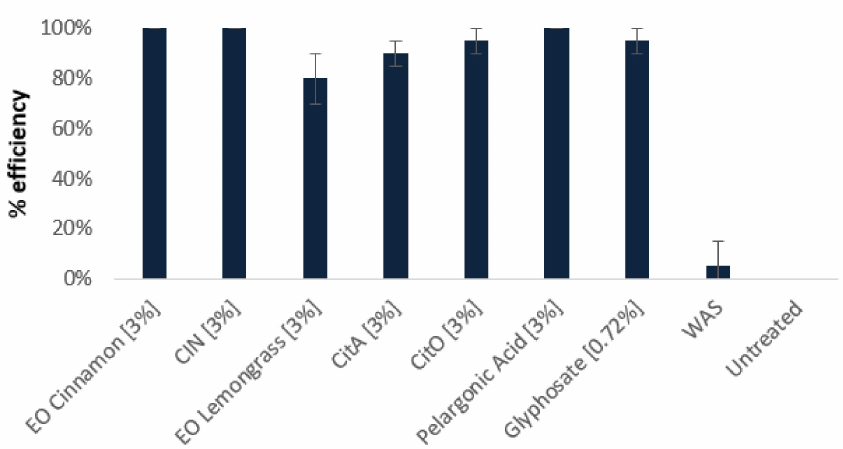
Figure 2. Herbicidal activity of cinnamon and Java citronella essential oils and their main components at 3%, CIN, CitA, and CitO respectively, after seven days. They are compared to glyphosate (0.72%) and pelargonic acid (3%) and to untreated plants or treated without active substance (WAS) (1% Tween 20 and 0.5% ethanol) – ( n =